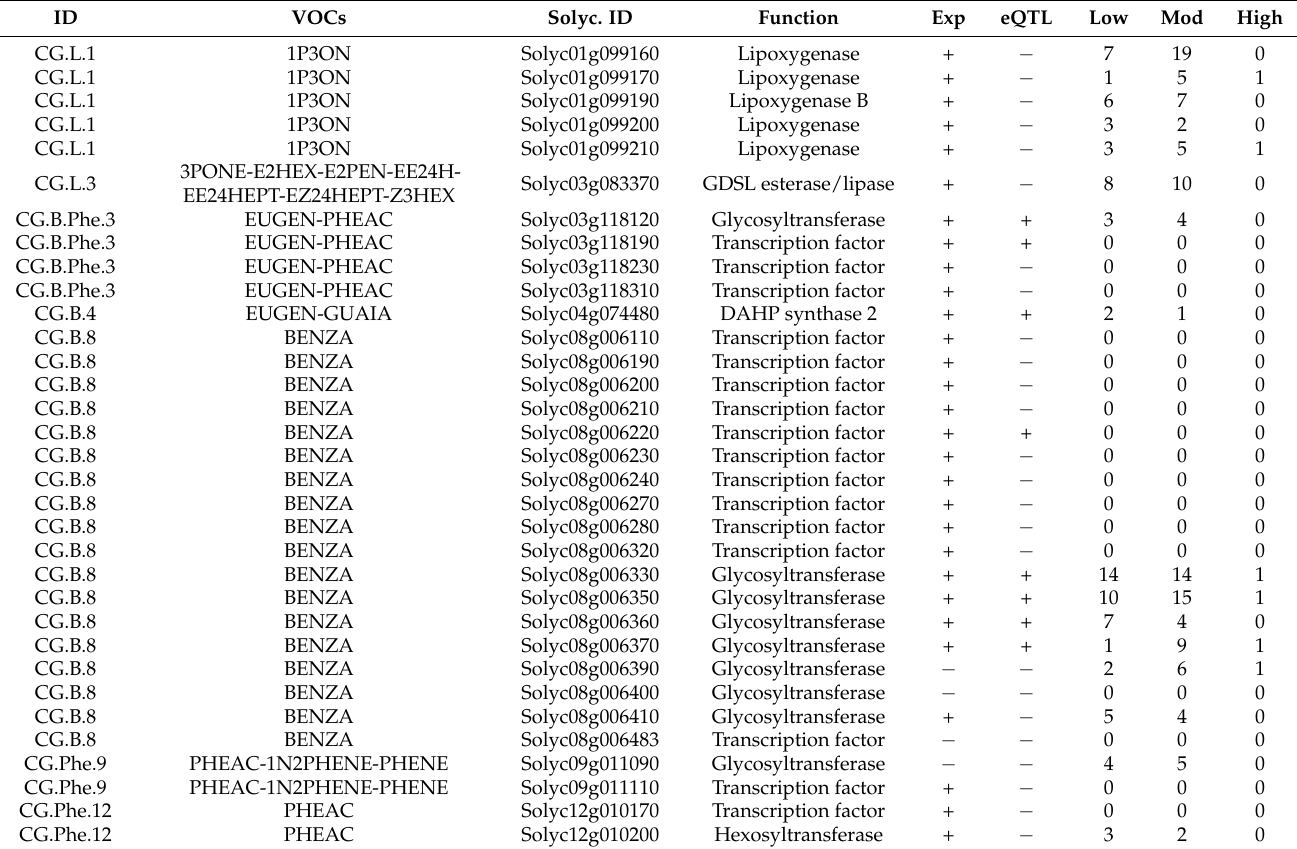
Table 3. Candidate genes and transcription factors identified in regions defined over associations for VOCs involved in tomato